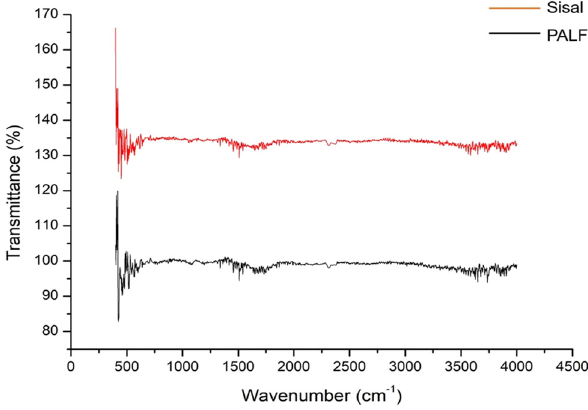
Figure 4: FTIR pattern of PALF and sisal fi ber composites.